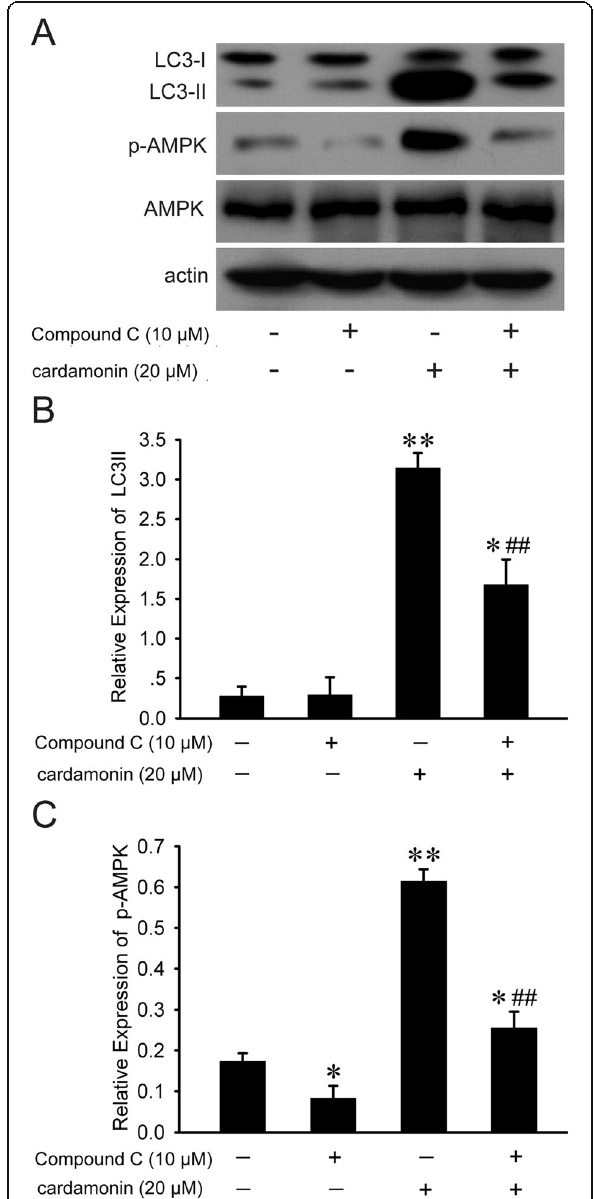
Fig. 4 The relationship between the activity of AMPK and autophagy by cardamonin. SKOV3 cells were treated with Compound C (10 μ M), cardamonin (20 μ M), Compound C (10 μ M) + cardamonin (20 μ M) for 48 h, respectively. a Expression of protein was detected by Western blot. b , c Quantification of protein by densitometry of Western blot performed above. * p < 0.05, ** p < 0.01 vs. control, ## p < 0.01 vs. cardamonin. Data were represented as mean ± SD, n =